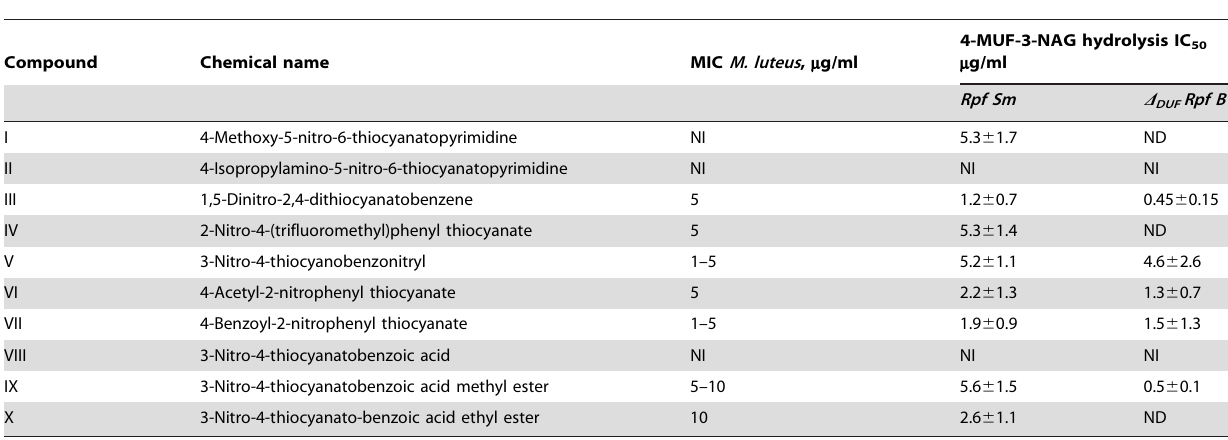
Table 1. Influence of NPT compounds on growth of some actinobacteria and on muralytic activity of Rpfs.